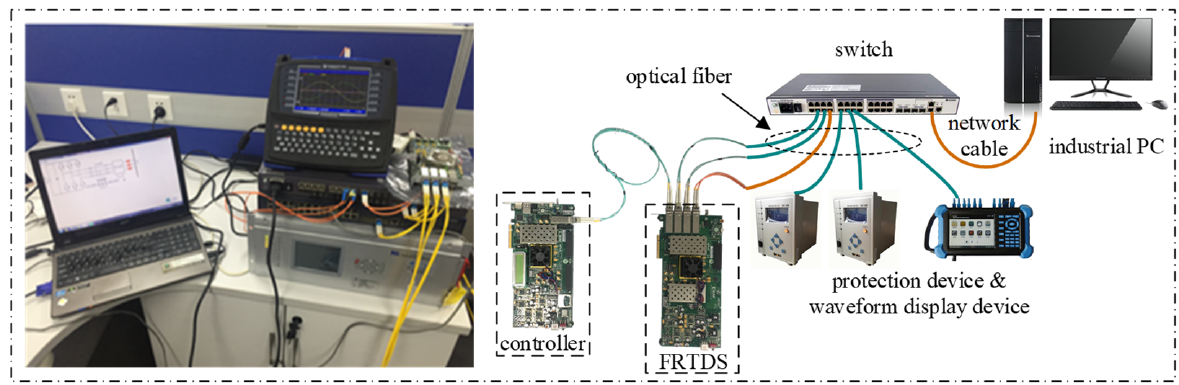
Figure 12. Hardware ‐ in ‐ loop system based on FRTDS. Figure 12. Hardware-in-loop system based on FRTDS.